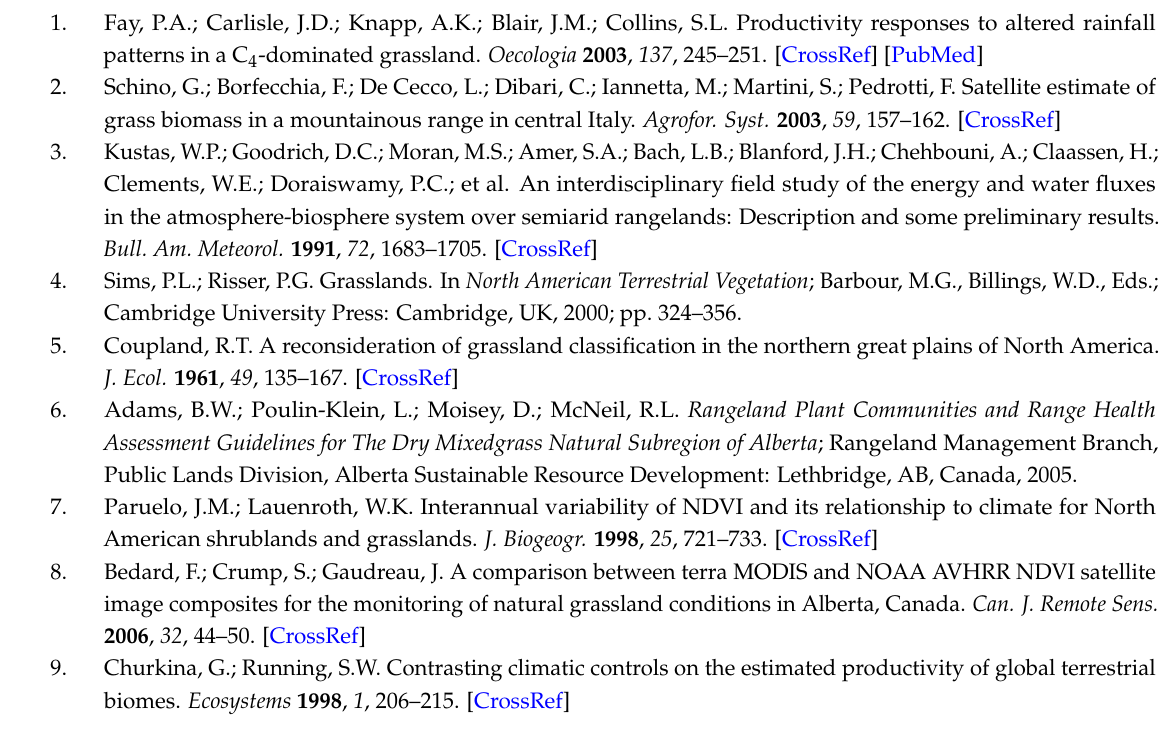
Figure S1: Effect of spatial aggregation and temporal filtering, Table S1: Mean site